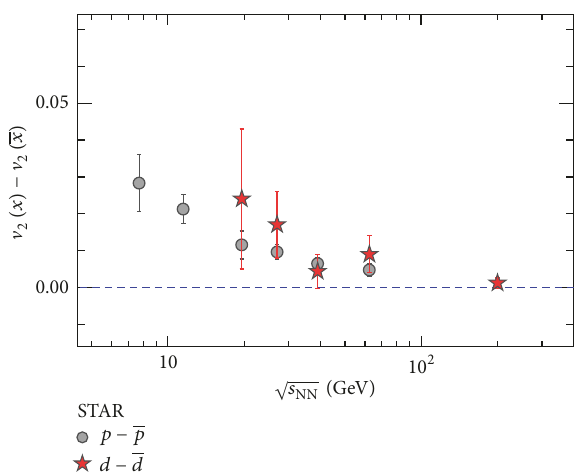
Figure 4: Difference of 𝑑 and 𝑑 V 2 (𝑝 𝑇 ) as a function of collision energy for minimum bias Au + Au collisions in